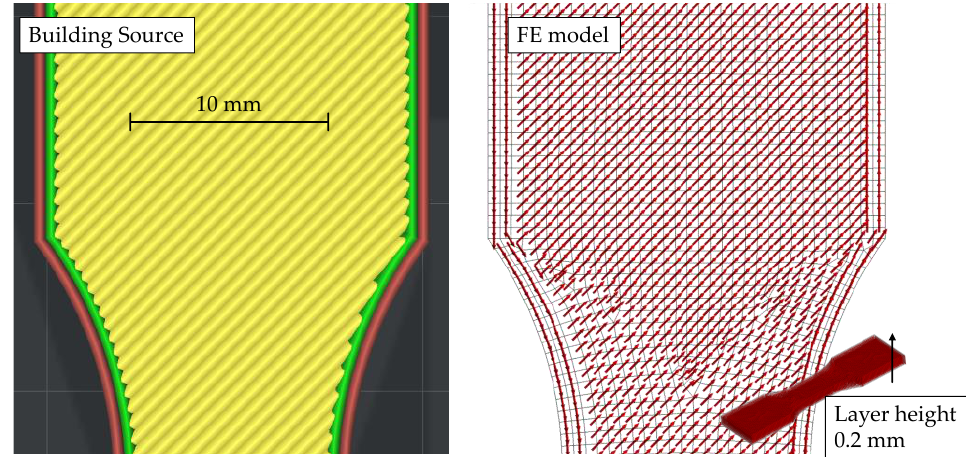
Figure 5. Building source (G-Code, left ) mapped to FE model ( right ) for the fourth specimen (F45°) using the approach presented by the authors [39].